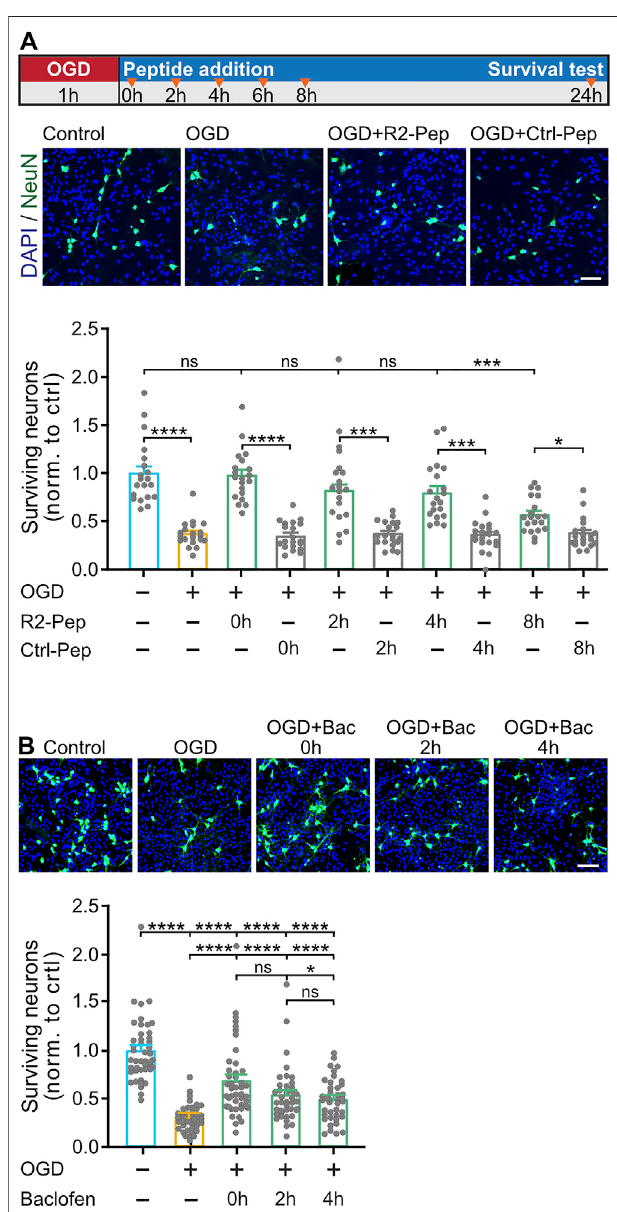
FIGURE 7 | R2-Pep limits OGD-induced neuronal death and is more effective than baclofen. A, OGD-stressed cultures were treated with R2-Pep or Crtl-Pep immediately (0 h), 2, 4, 6 or 8 h after the stress. After 24 h the cultures were immunostained for neurons (NeuN, green) and total cells (DAPI, blue).Top:schemeofexperimentaldesign. Middle: representativeimages (scalebar:100 μ m).Bottom:Quanti fi cation ofsurvivingneurons.Thevalueofthe untreatedculturesservedascontrol.Thedatarepresentthemean±S.E.M.of20 frames( fi eldsofview)foreachexperimentalconditionderivedfrom2independent experiments. ns: p > 0.05; *, p < 0.05; ***, p < 0.001; ****, p < 0.0001; Brown- Forsythe/Welch one-way ANOVA followed by Dunnett ’ s T3 multiple comparison test. B, OGD-stressed cultures were treated with baclofen immediately (0 h), 2 h or 4 h after the stress. After 24 h the cultures were immunostained for neurons (NeuN, green) and total cells (DAPI, blue). Top: representative images (scale bar: 100 μ m). Bottom: Quanti fi cation of surviving neurons. The value of the untreated cultures served as control. The data represent the mean ± S.E.M. of 40 – 45 framesforeachexperimentalconditionderivedfrom3independentexperiments. ****, p < 0.0001; one-way ANOVA with Tukey ’ s multiple comparisons test.